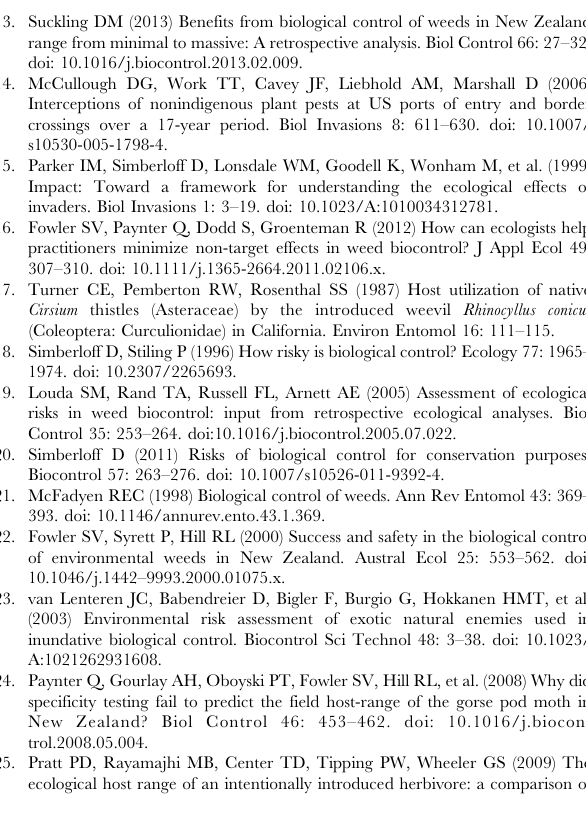
Table S1 Non-target impacts recorded from biological control agents of weeds on other plants, on a five step scale of